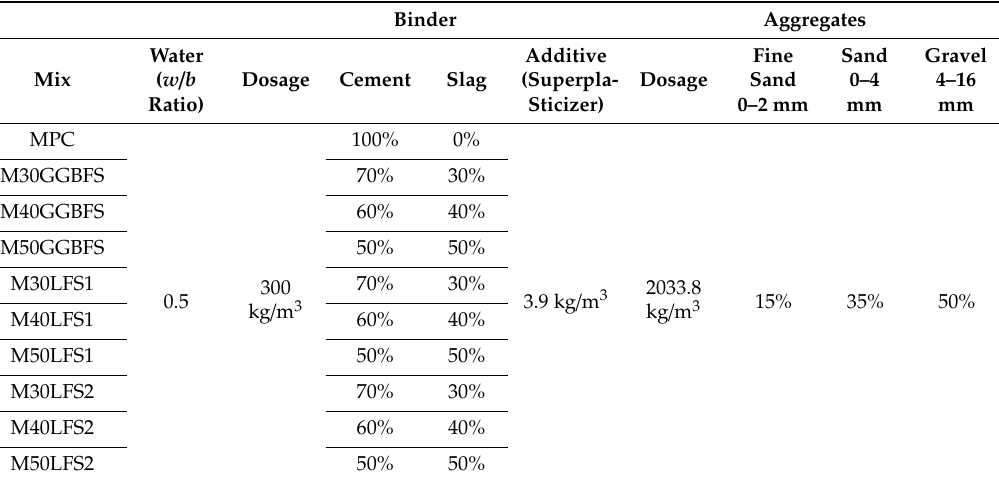
Table 2. Concrete mixture